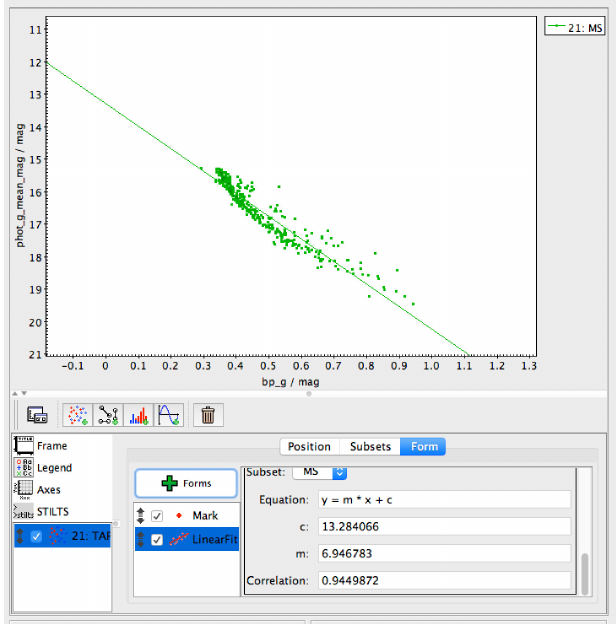
Fig. 71.— Linear fit to the main sequence stars of NGC 188 lipses, or a text label, can be added in the same way we have added the linear fit.